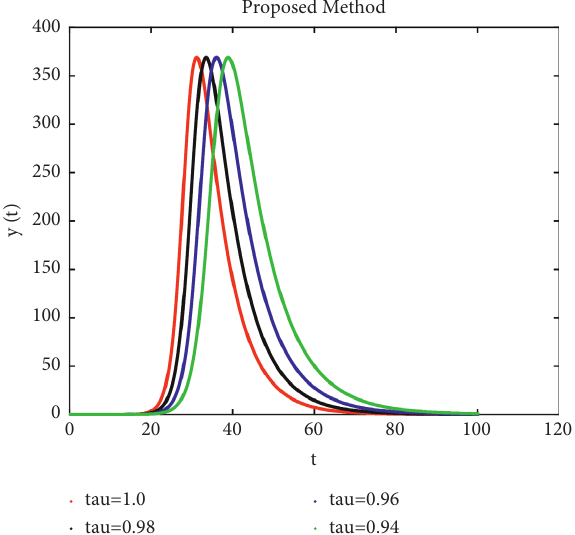
Figure 15: Dynamics of infected cells at τ � 1 and various fractional order under Mittag-Leffler kernel.